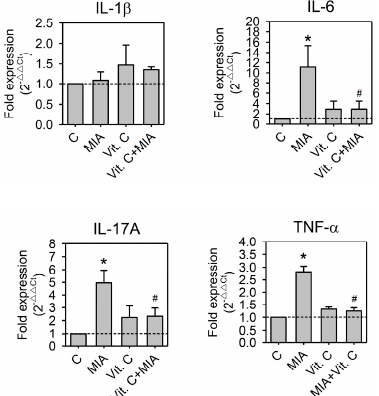
Figure 6. Effects of MIA and/or vitamin C on pro-inflammatory cytokine expressions. SW1353 cells were incubated with 100 μ M vitamin C in the presence or absence of 5 μ M MIA for 24 h; then, the cells were harvested and the mRNA was extracted, followed by reverse transcription and real-time PCR analysis for IL-1 β , IL-6, IL-17A, and TNF- α . The data are expressed as fold changes compared to that in untreated control. The dashed line shows Y = 1 of control for reference. The results are the mean ± S.D. for three separate experiments, each in triplicate. * p < 0.05 compared to the untreated control. # p < 0.05 compared to the MIA treated group.